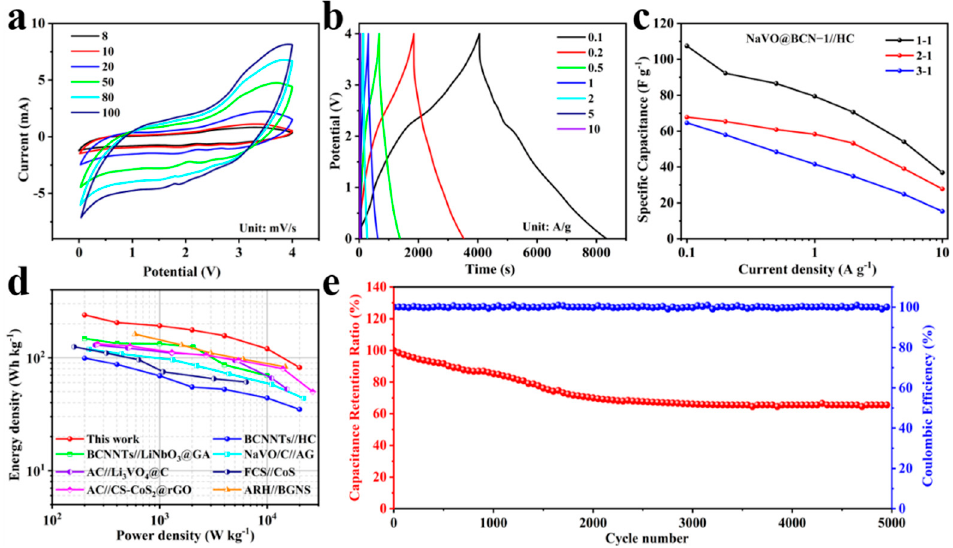
Figure 4. ( a ) CV curves of the NaVO@BCN-1//HC LIC; ( b ) GCD curves of the NaVO@BCN-1//HC LIC; ( c ) specific capacitance of the LICs with different cathode and anode mass ratios; ( d ) Ragone plots of the NaVO@BCN-1//HC LIC and other advanced LICs in previous work; ( e ) cycling performance of the NaVO@BCN-1//HC LIC from 0 ‒ 4 V at 10 A g ‒ 1 .